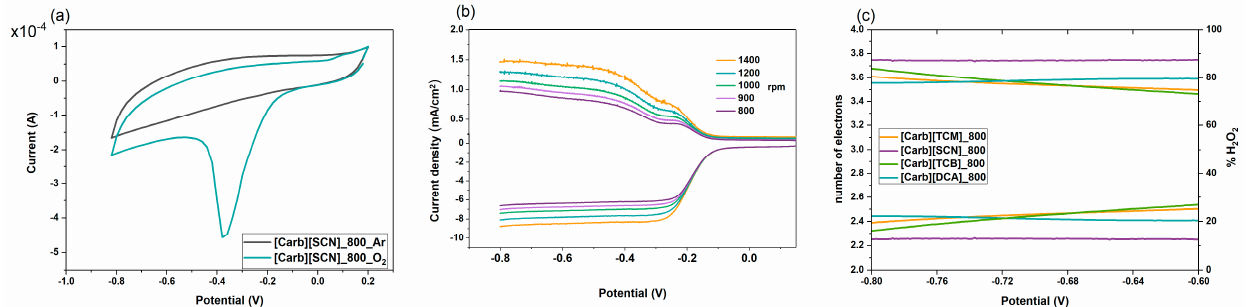
Figure 4. ( a ) CV curves recorded for [Carb][SCN]-derived carbon, deposited on a GC electrode in O 2 - and Ar-saturated 0.1 M KOH at a scan rate of 50 mV/s; ( b ) LSV recorded for [Carb][SCN]-derived carbon deposited on a GC electrode in O 2 -saturated 0.1 M KOH at a scan rate of 50 mV/s; ( c ) electron-transfer numbers and peroxide yields (H 2 O 2 %) calculated from RRDE measurements registered in O 2 -saturated 0.1 M KOH at a scan rate of 50 mV/s for carbohydrate-derived carbons synthesized at 800 °C.